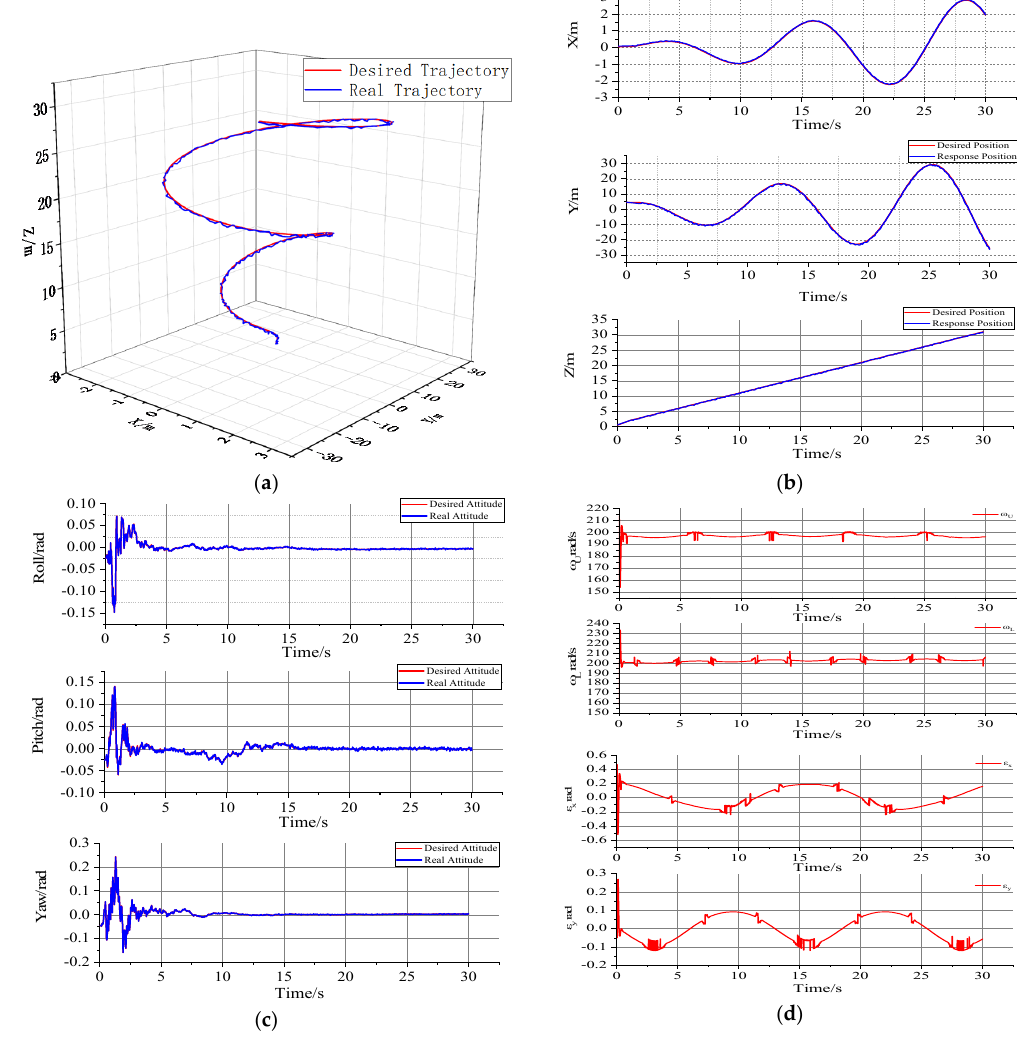
Figure 4. Numerical simulation under aerodynamic interference. ( a ) Three-dimensional trajectory tracking; ( b ) expected and actual position responses; ( c ) expected and actual attitude response diagrams; ( d ) the virtual control input.